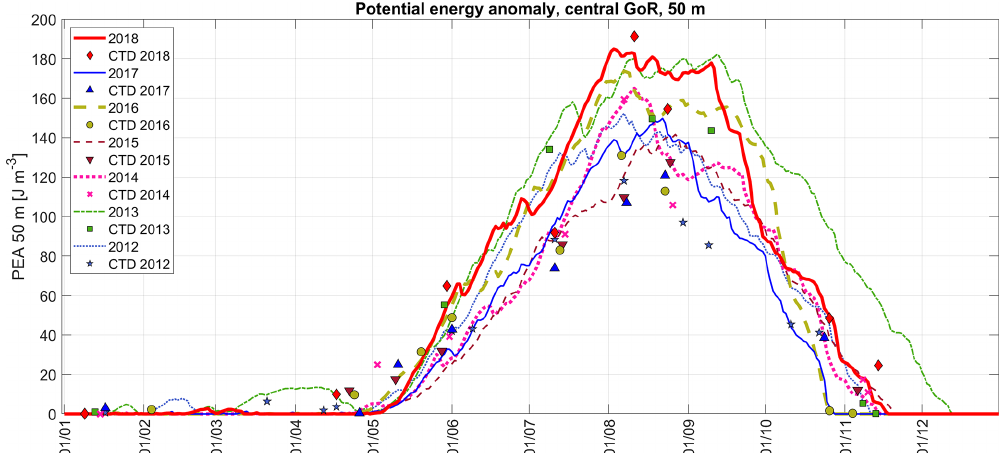
Figure 7. Changes in vertical stratification (potential energy anomaly, PEA, characterizing energy needed to mix the water column fully) in the central Gulf of Riga in 2012–2018 based on CTD profiles (markers) and estimated using meteorological (ERA5 data are from the central Gulf of Riga) and river runoff data (curves; the methods are presented in Sect.